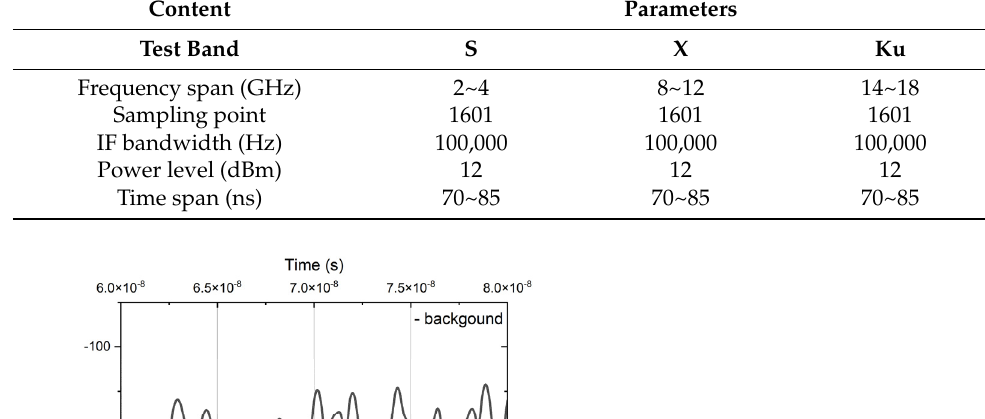
Table 1. Parameters of the network analyzer.